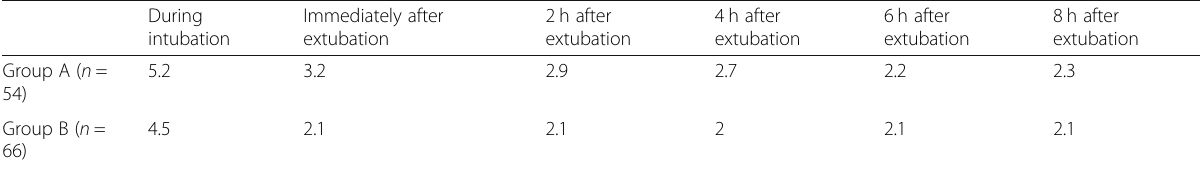
Table 3 Sedation score during intubation and after extubation (data are presented as the mean) During intubation